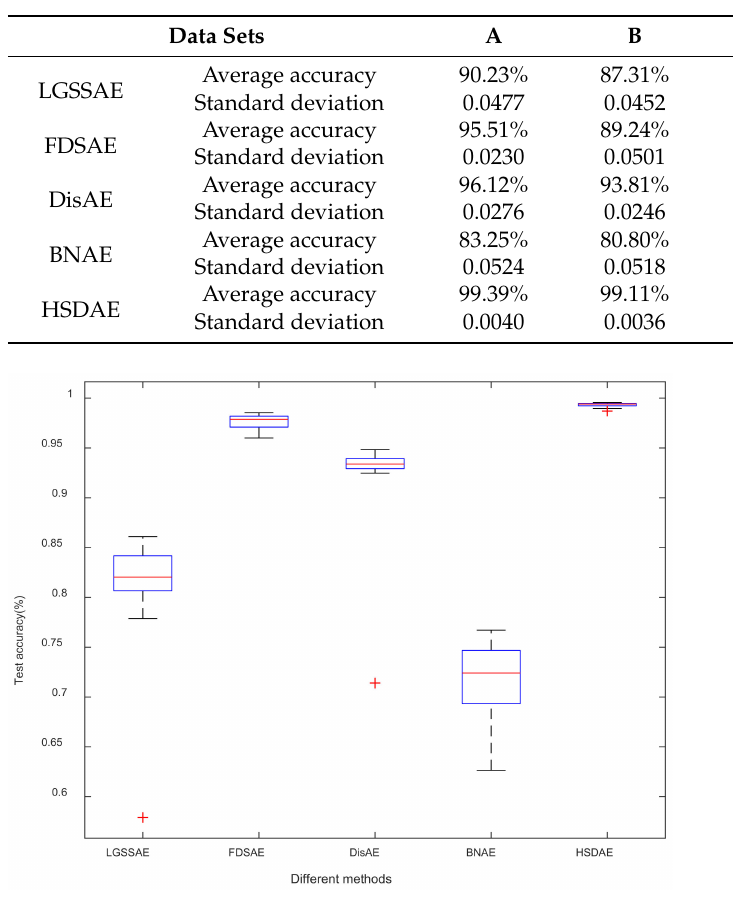
Figure 10. Comparison of experimental results of different methods in data set